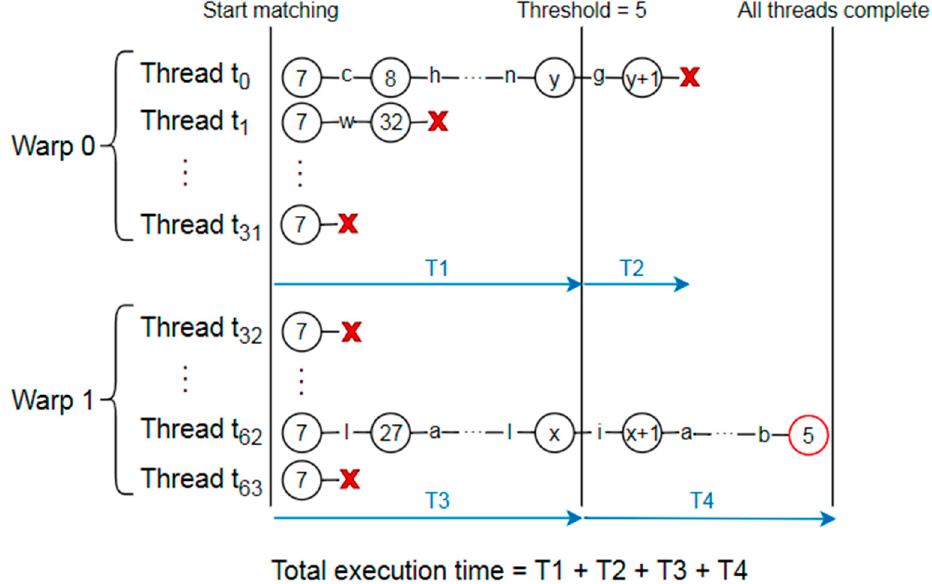
Figure 2. Load imbalance in the original PFAC algorithm.